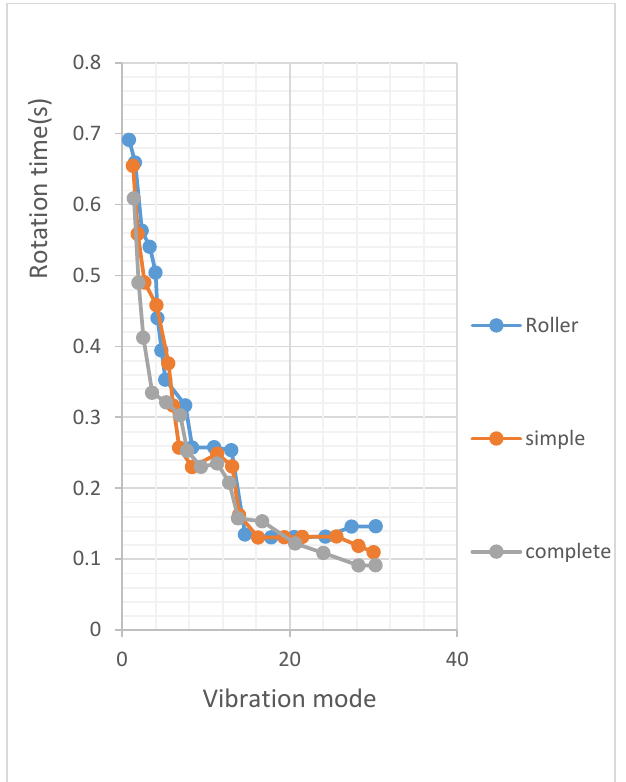
Fig. 10. Five- span bridge with a base height of 8